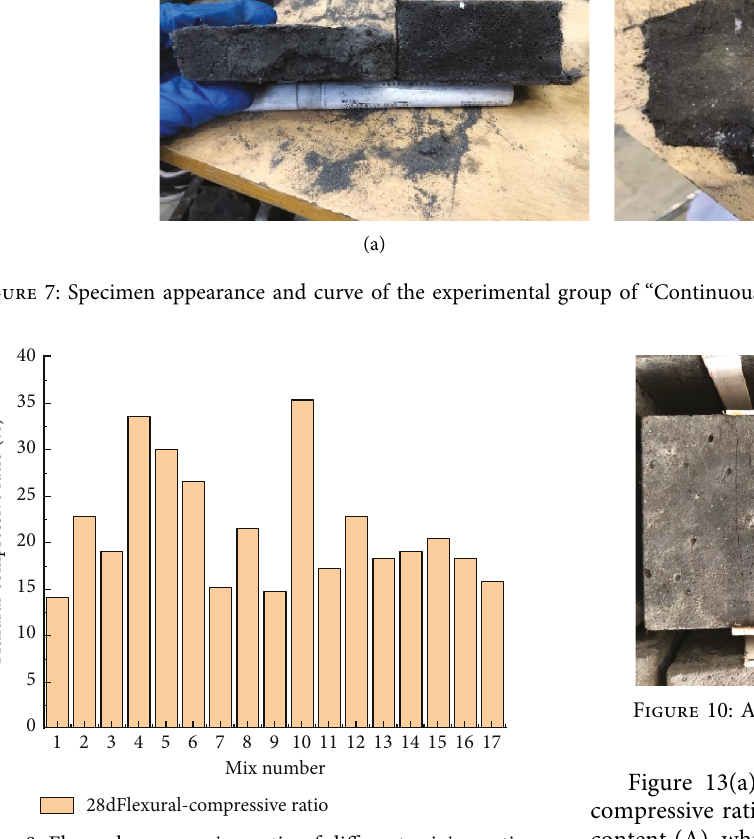
Figure 8: Flexural-compression ratio of different mixing ratios.